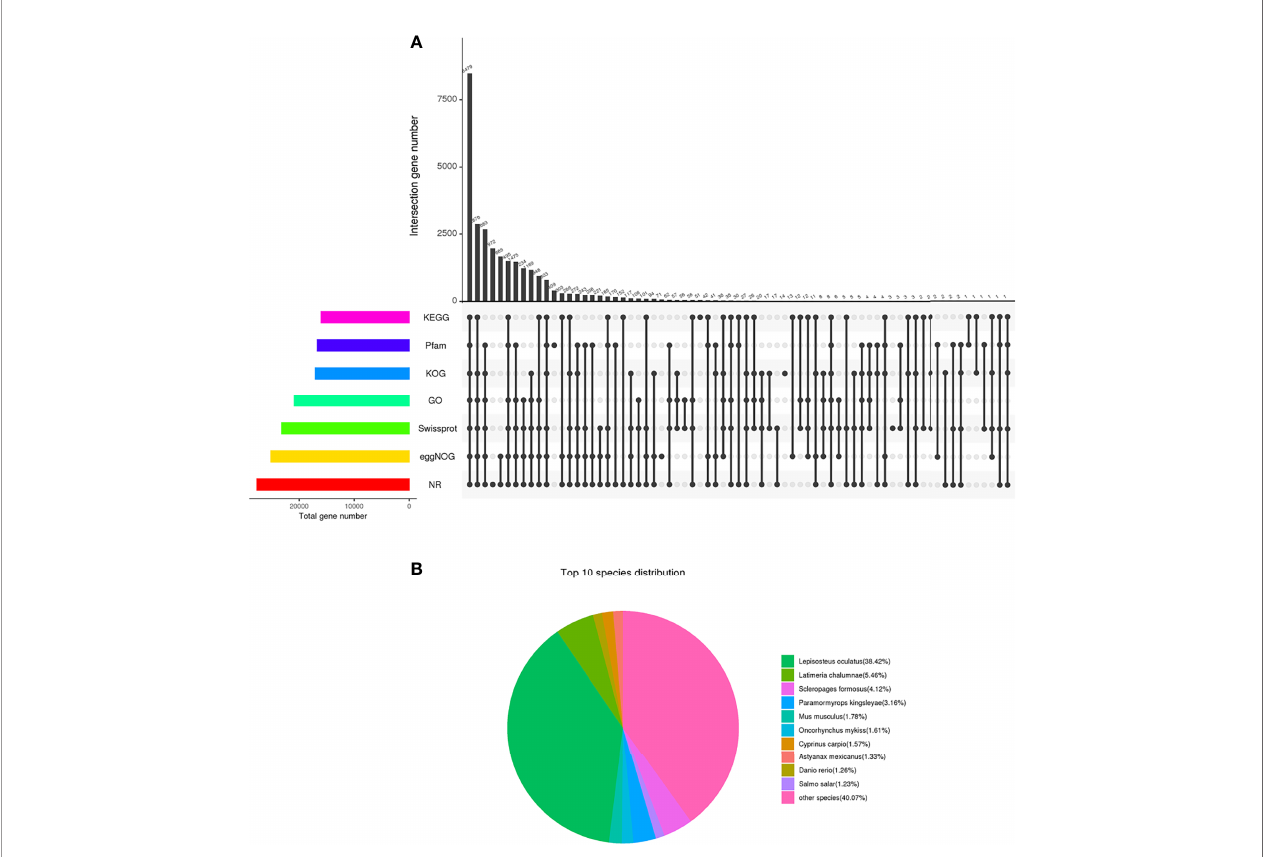
FIGURE 2 | The database annotation results of the unigene. (A) Venn diagram of each database annotation. the number on the top of the bar represents the result of the intersection of the databases with black dots in the following matrix, and the column on the left represents the number of unigene annotated in all databases. (B) Species comparison distribution of unigenes in NR